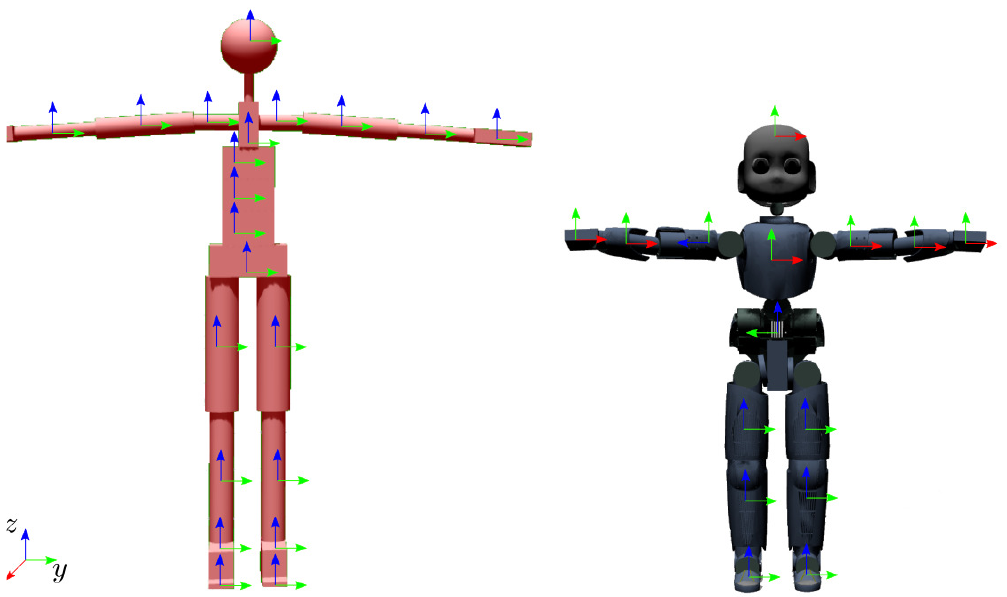
Figure 4. Model of the human ( left ) and iCub ( right ) in T-pose , with the corresponding links frame